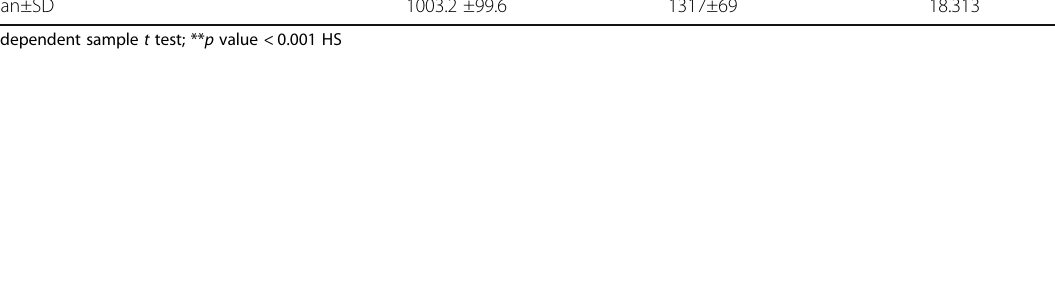
Table 8 Group A compared to group B according to needs of analgesia (morphine “ mg ” ) 2nd dose and 3rd dose Needs for analgesia Group A ( n =50) Group B ( n =50) χ 2 p value 1st dose at (12 h) 30 (60%) 10 (20%) 5.104 2nd dose at (24 h) 23(46%) 5